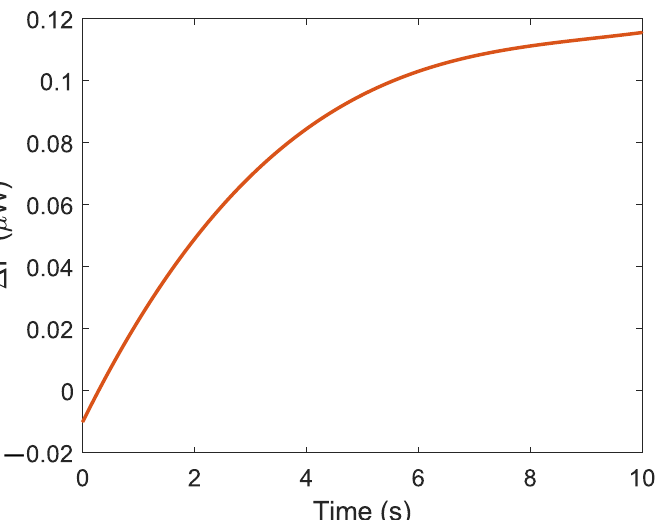
Figure 10. Simulated transient evolution of average power difference ∆ P between FAR and Switch- only for R L = 48k Ω